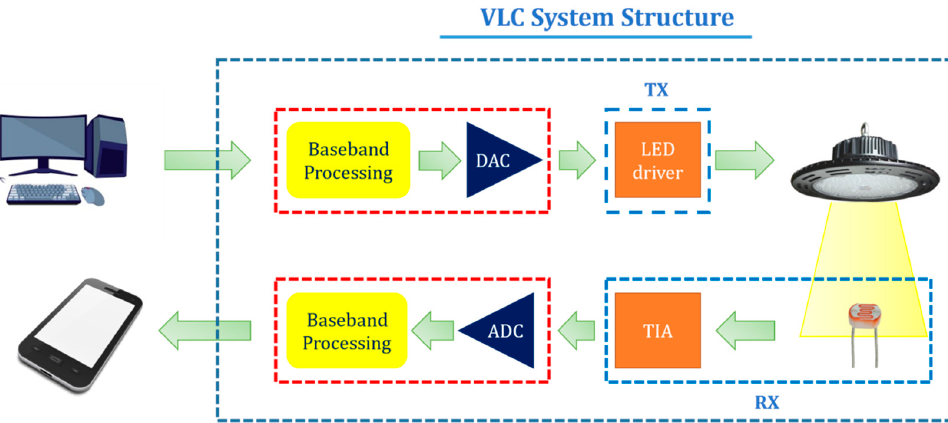
Figure 1. A schematic of a VLC System (Tx: Transmitter; Rx: Receiver; DAC/ADC: Digital/Analog converter; TIA: Transimpedance amplifier).